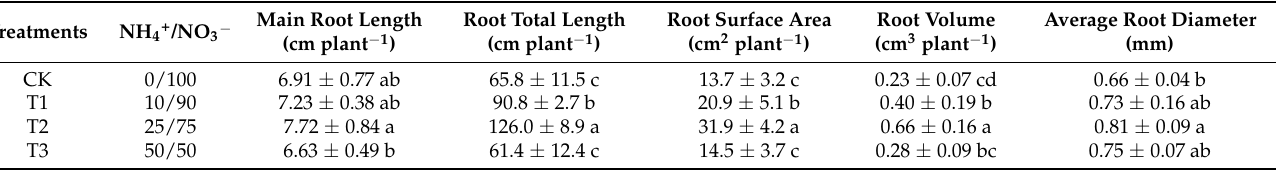
Table 3. Effects of different NH 4+ /NO 3 − ratios on root morphological indices of Chinese kale